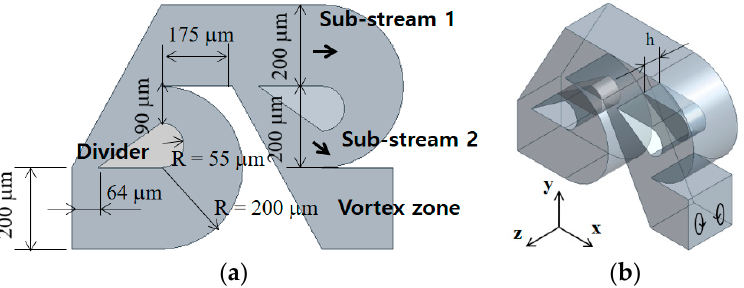
Figure 1. Schematic diagram of the modified Tesla mixing unit (non-proportional): ( a ) Front view and ( b ) Three-dimensional view.